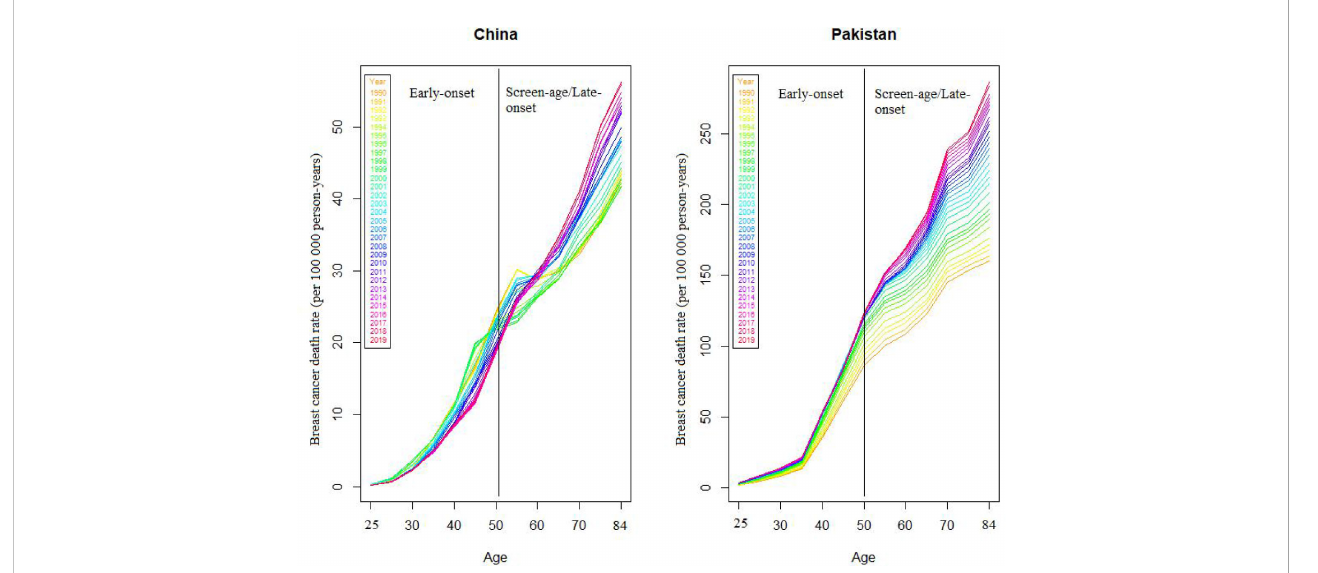
FIGURE 1 Death rates (per 100,000) due to female breast cancer in China and Pakistan, 1990 –